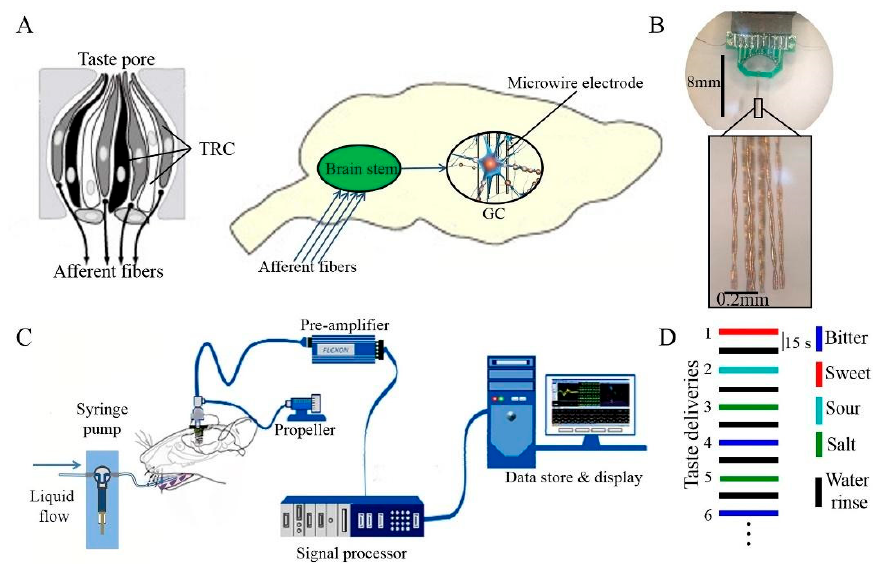
Figure 3. Bitterness biosensor constructed with rat’s gustatory cortex. ( A ) Scheme of a rat gustatory system and the taste information pathway from taste buds via brain stem to microwire electrodes; ( B ) the microelectrode array employed in biosensor; ( C ) the schematic diagram of the whole animal- based biosensor; ( D ) the test order of different taste deliveries. Reproduced from [114] with permis- sion from Elsevier.